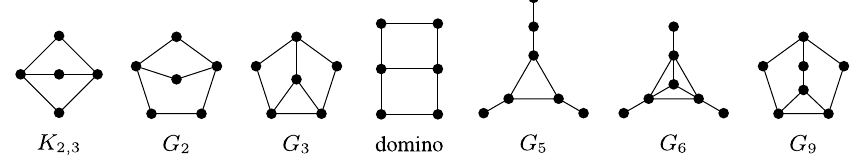
Fig. 4: Some forbidden induced subgraphs for the class of circular-arc